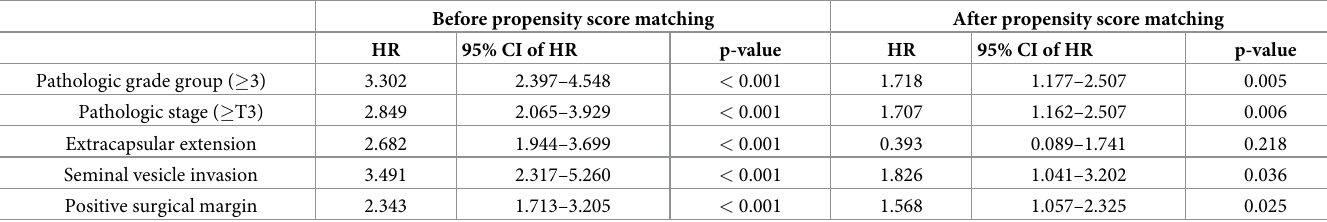
Table 2. Multivariate analyses for the impact of Ki-67 on various pathologic outcomes after surgery. Before propensity score